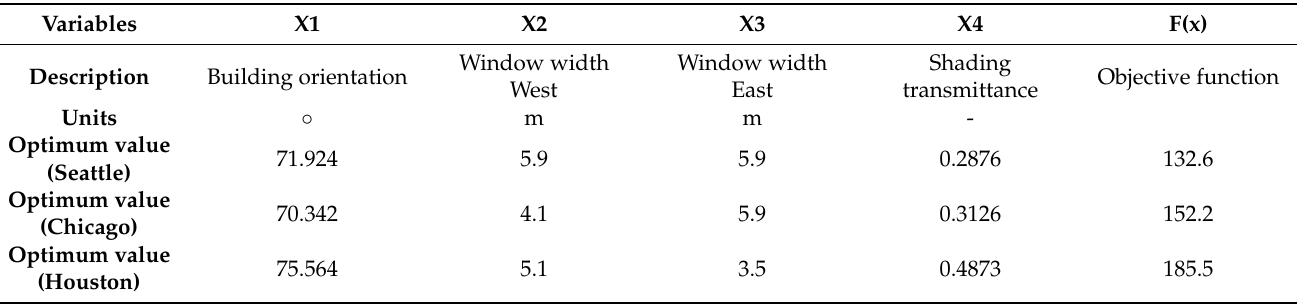
Figure 6. Box-Whisker plots of the results comparison for a simple office. Table 7. Optimized decision variables of the simple office